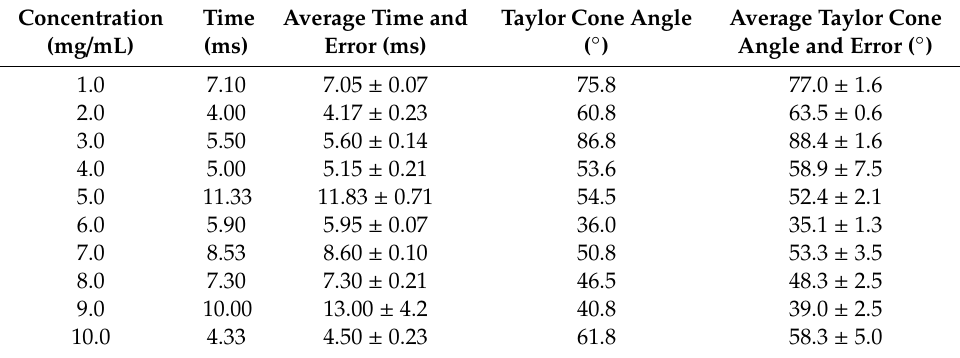
Table 1. The formation time and the angles of Taylor cones at di ff erent